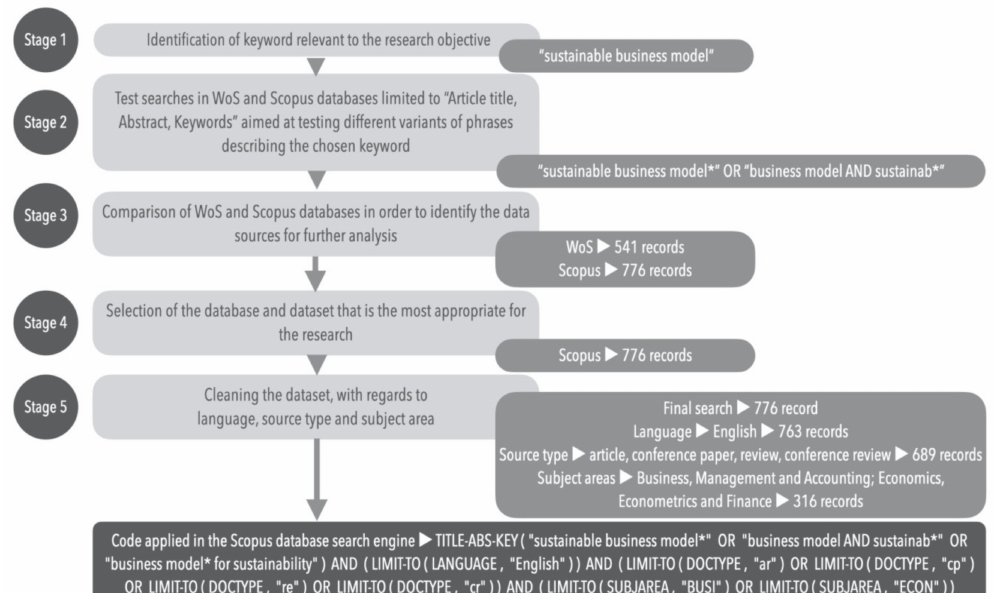
Figure 1. Stages of the research procedure. Source: own